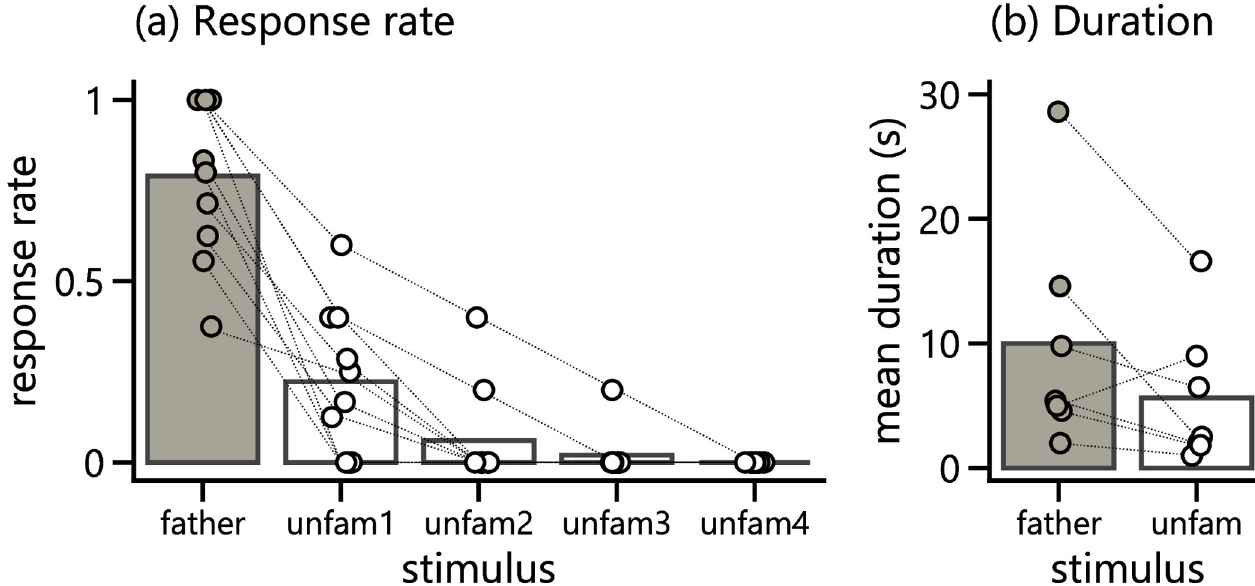
Fig 2. Females performed more CSDs to their father’s song. (a) Response rate of CSDs to each stimulus ( n = 10). Five songs are aligned in descending order of response rate. (b) Mean total duration of CSDs expressed during presentation of the father’s song and unfamiliar songs ( n = 7). In both panels, dots connected with broken lines show individual data, while bars indicate the population